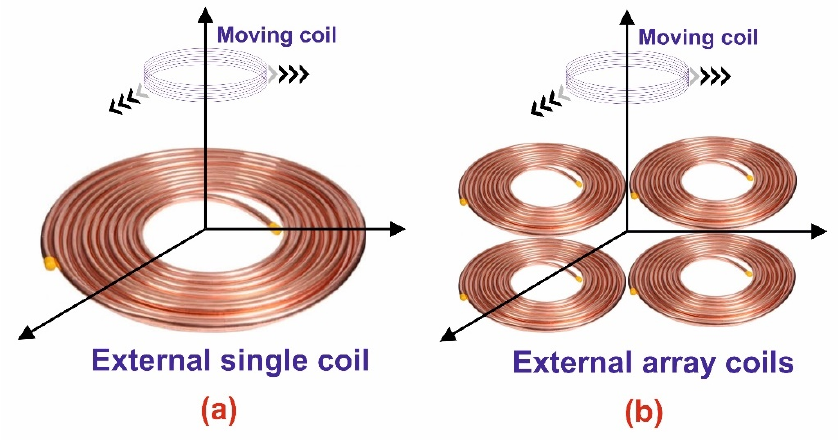
Figure 1. Schematic of inductive WPT system for ( a ) single external coil and ( b ) array external coil for free-moving object.